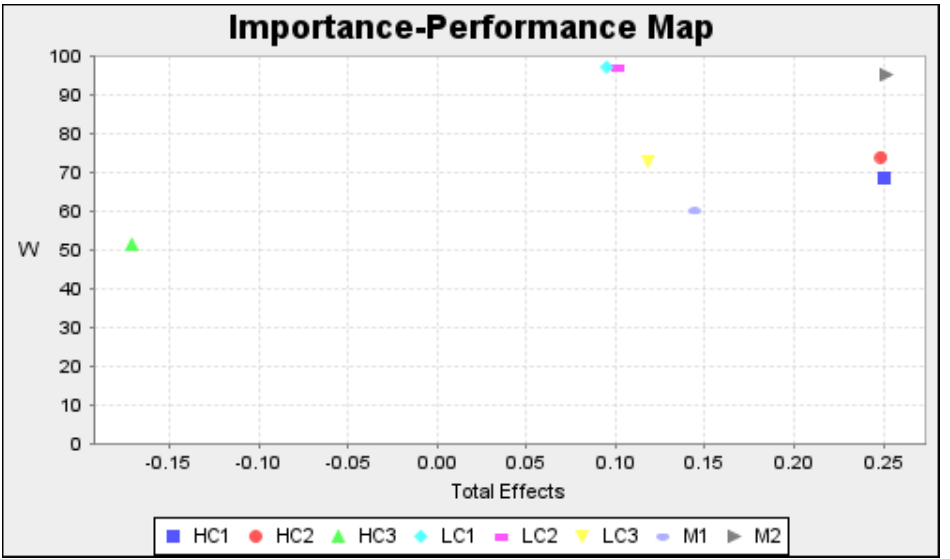
Figure 2. Importance: Performance analysis of the model indicators to Wages (W). Source: Authors.